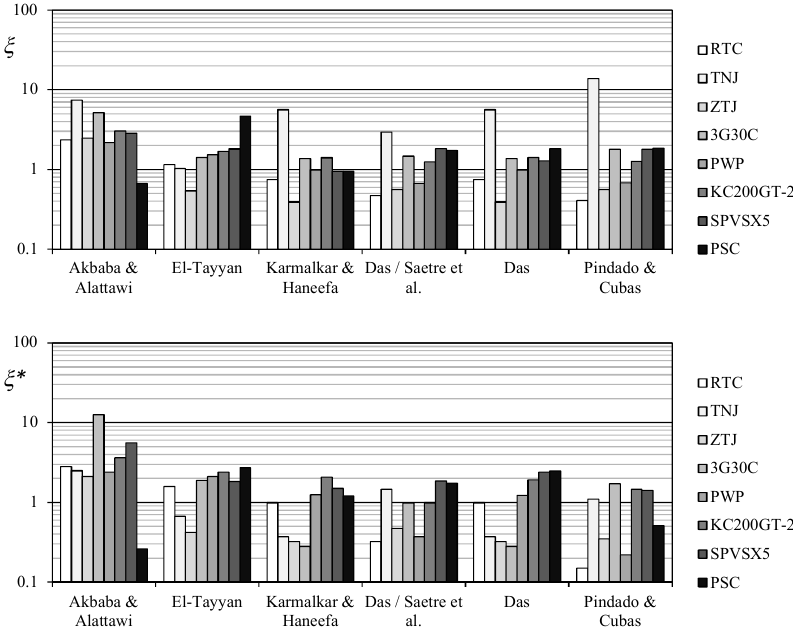
Figure 13. Comparison of the different explicit models studied, computationally fitted (best fit) to the I – V curves selected for the benchmark (Table 2). Normalized RMSE, ξ , (Equation (37)), and normalized RMSE within ±5% of V oc around the maximum power point, ξ *. See also Tables 3–8.